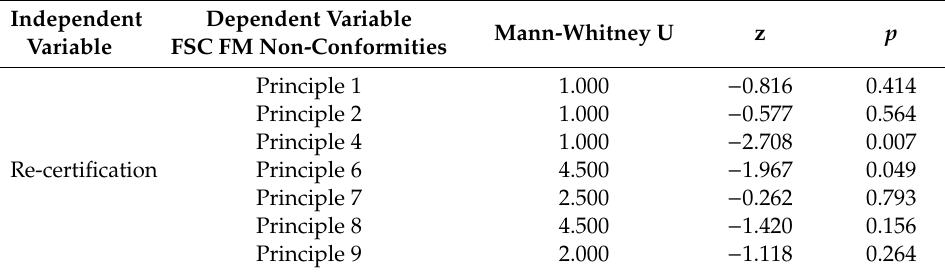
Table A2. Statistical results of Mann-Whitney U test *.